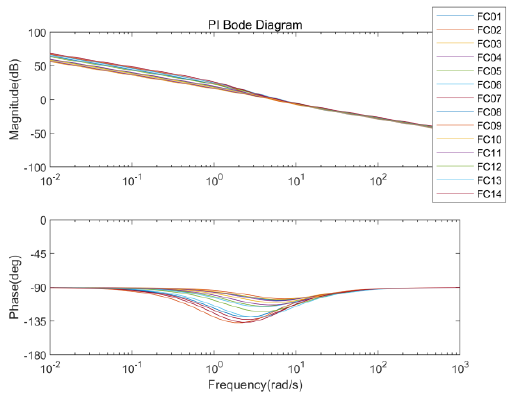
Figure 9. Bode plots of C PI ( s ) P i ( s ) , i = 1,2, · · ·